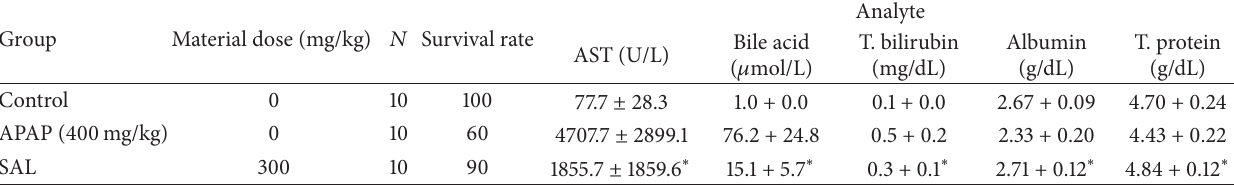
Table 3: Effect of SAL (300 mg/kg) on the major biomarkers of liver in APAP model. Group Material dose (mg/kg) 𝑁 Survival rate